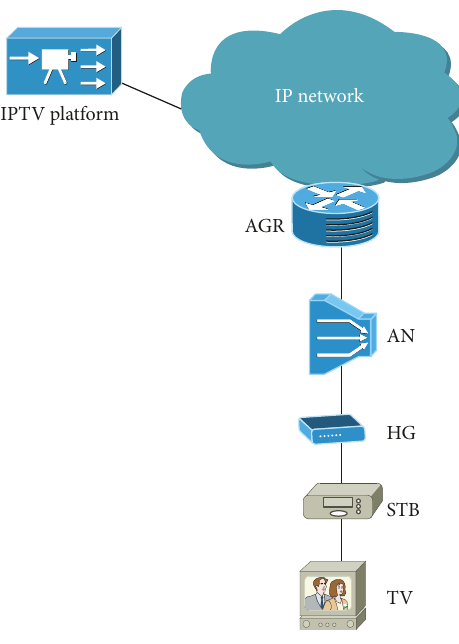
Figure 1: Architecture of the IPTV system.